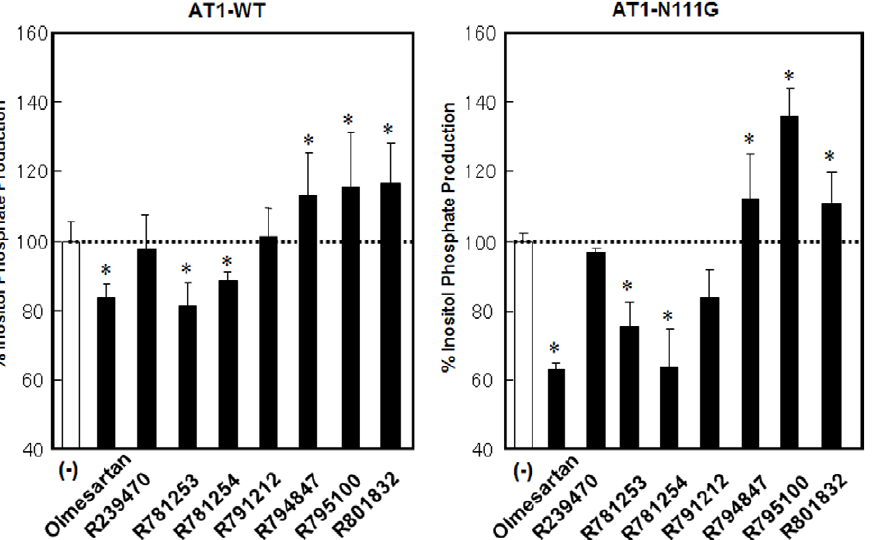
Figure 3. Changes in cysteine accessibility in COS1 cells expressing C76A/C289A mutant receptors in which the transmenbrane 3 residues from Ala 106 to Phe 117 , except for position 113, were successively replaced by cysteine. 1 m M of ARBs, n=4–9, *p , 0.05 vs. no treatment. # p , 0.05 vs. C76A/C289A. doi:10.1371/journal.pone.0037974.g003 PLoS ONE |